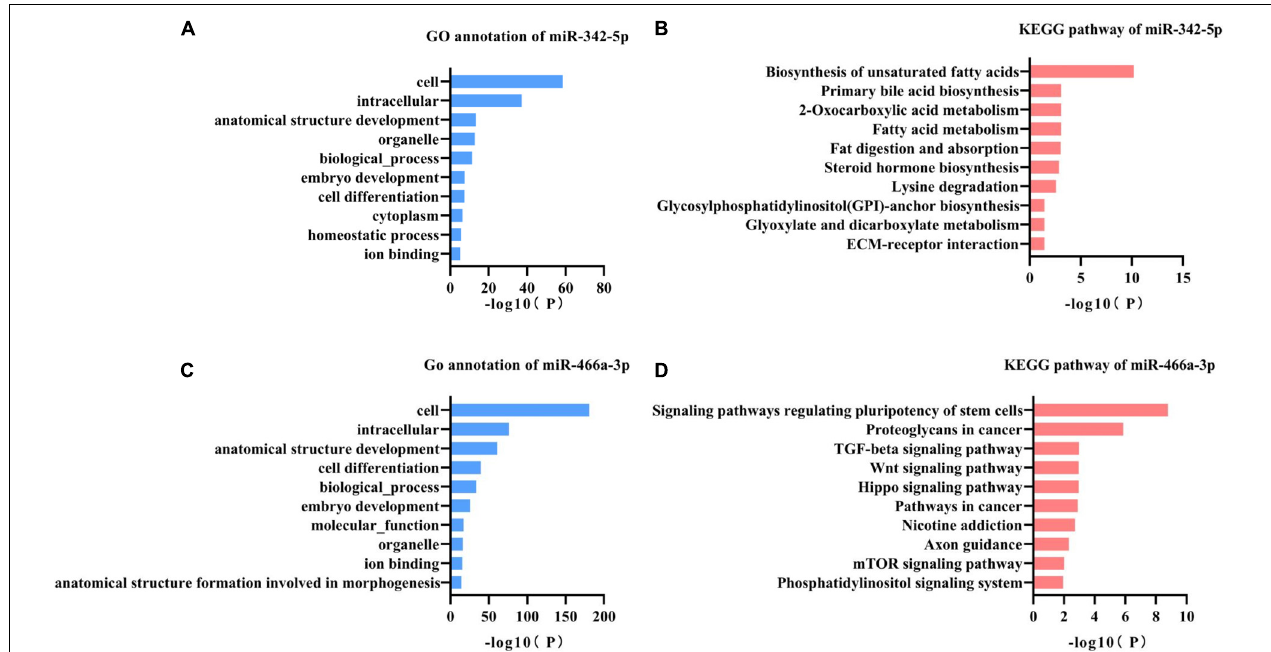
FIGURE 3 | GO annotation and KEGG pathway analysis of miR-342-5p and miR-466a-3p. (A,B) GO annotation and KEGG pathway analysis of miR-342-5p obtained from miRPath V3.0. (C,D) GO annotation and KEGG pathway analysis of miR-466a-3p obtained from miRPath V3.0.